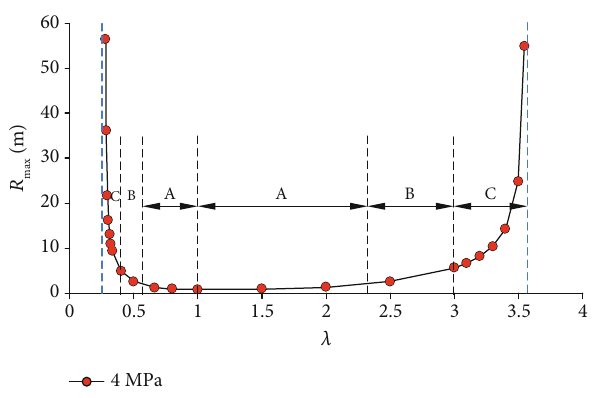
Figure 4: Complete stress ratio curve.